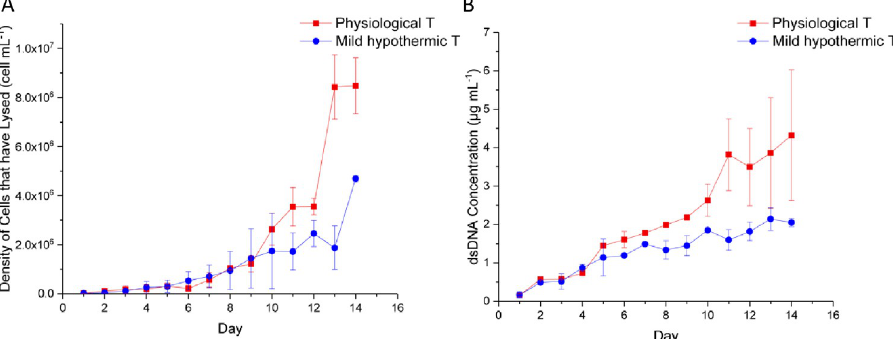
Fig 3. (A) Concentration of cells that have lysed as inferred from the results of the LDH assay; (B) Double stranded DNA concentration in the